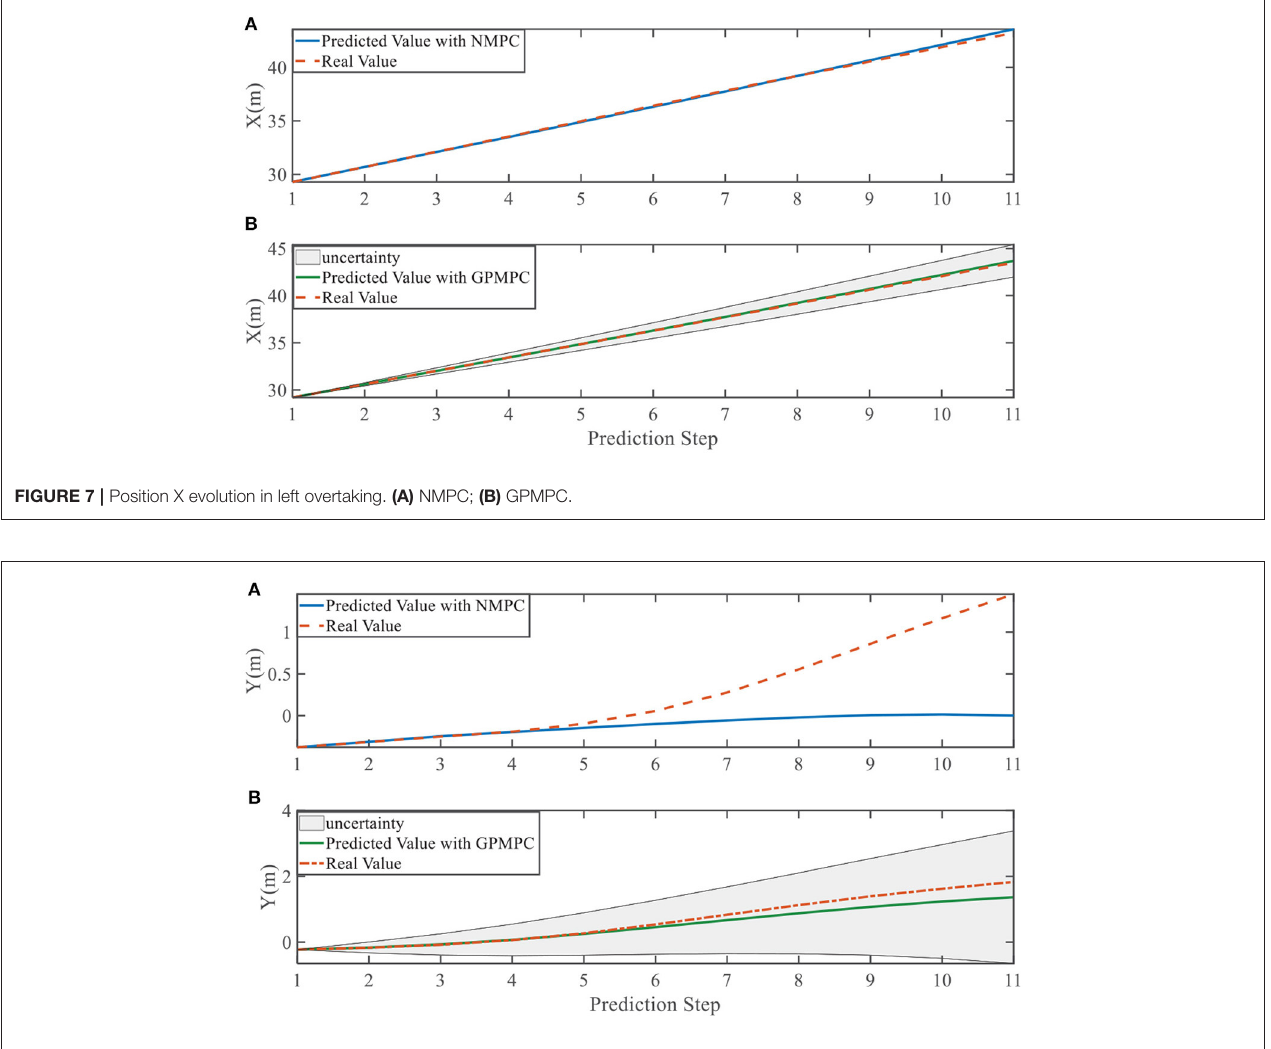
FIGURE 8 | Position Y evolution in left overtaking. (A) NMPC; (B) GPMPC.